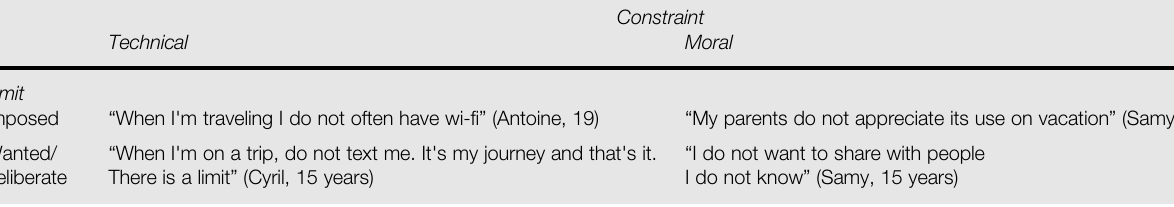
Table II Limited use of social networks by Generation